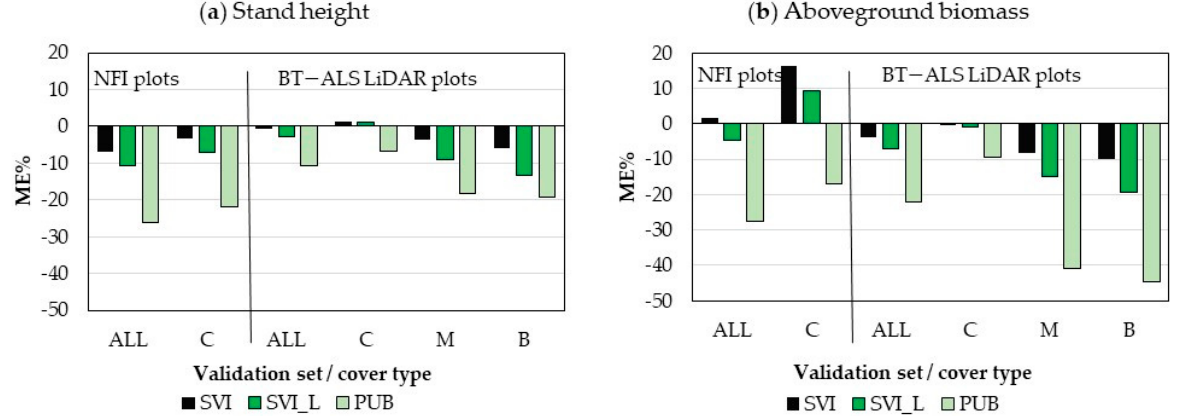
Figure 9. Percent mean error (ME%) for ( a ) stand height and ( b ) AGB relative to the validation datasets comprising NFI plots and BT − ALS LiDAR plots using all samples (ALL) then partitioned by forest cover type (C: conifer, M: mixedwood, B: broadleaf) for SVI maps compared to Landsat-based SVI_L maps and published (PUB) maps.